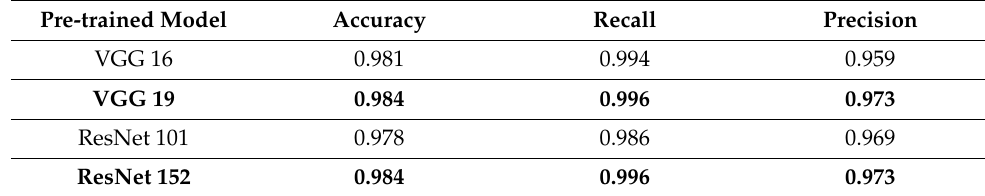
Table 2. Performance using logistic regression.